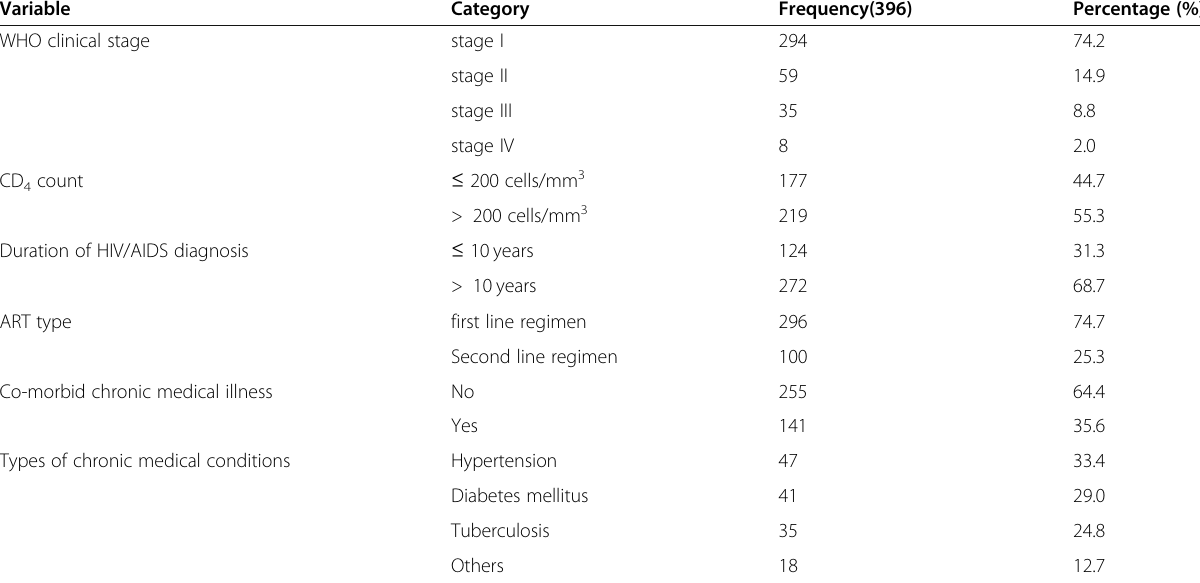
Table 2 HIV related clinical characteristics of people living with HIV/AIDS on follow up at Zewditu Memorial Hospital, Addis Ababa, Ethiopia, 2018.(n = 396) Variable WHO clinical stage